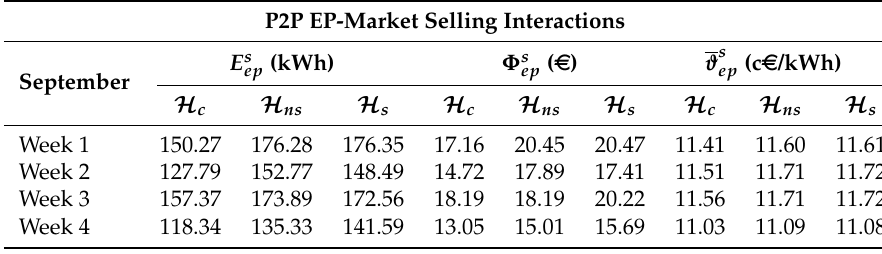
Table 6. P2P energy-package market selling interactions.